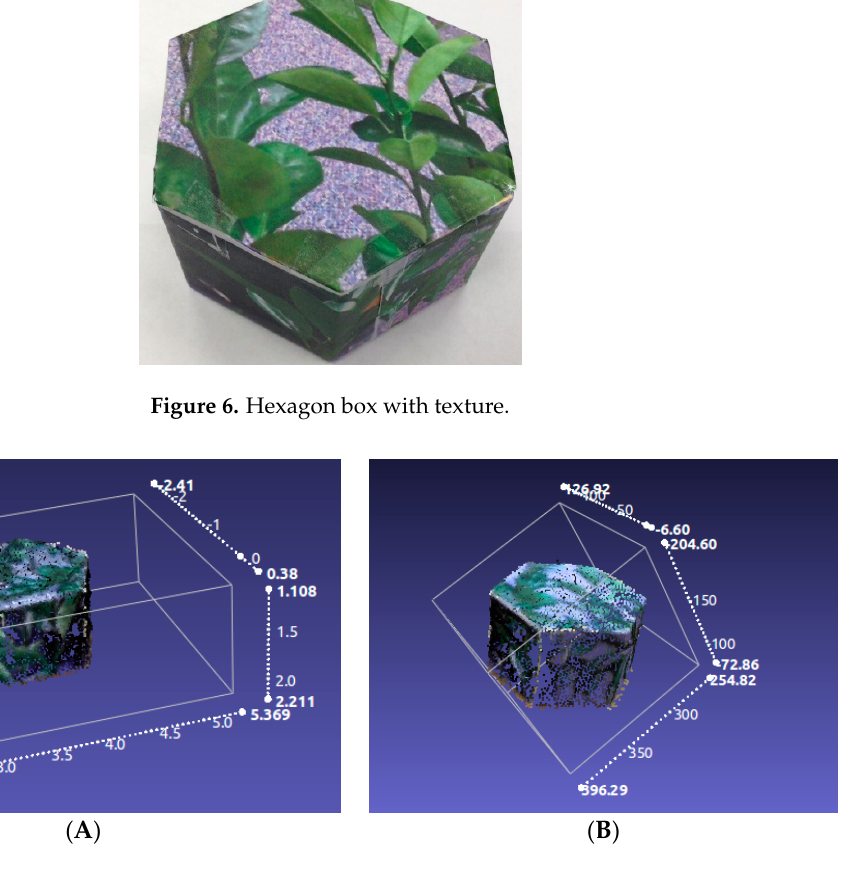
Figure 7. 3D reconstruction. ( A ) projective reconstruction; ( B ) metric reconstruction.